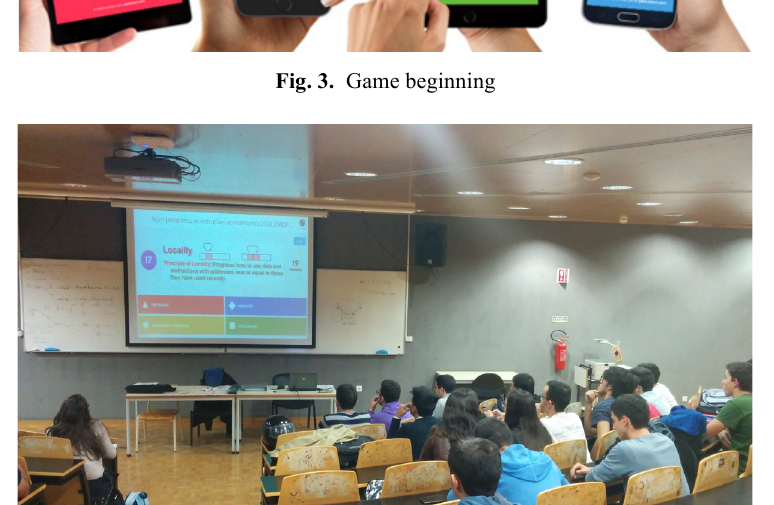
Fig. 4. Students playing Kahoot